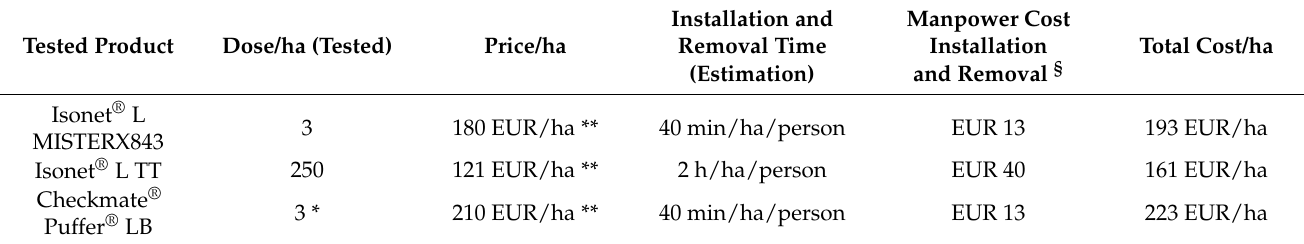
Table 4. Economic evaluation of the three products evaluated in this study for Lobesia botrana mating